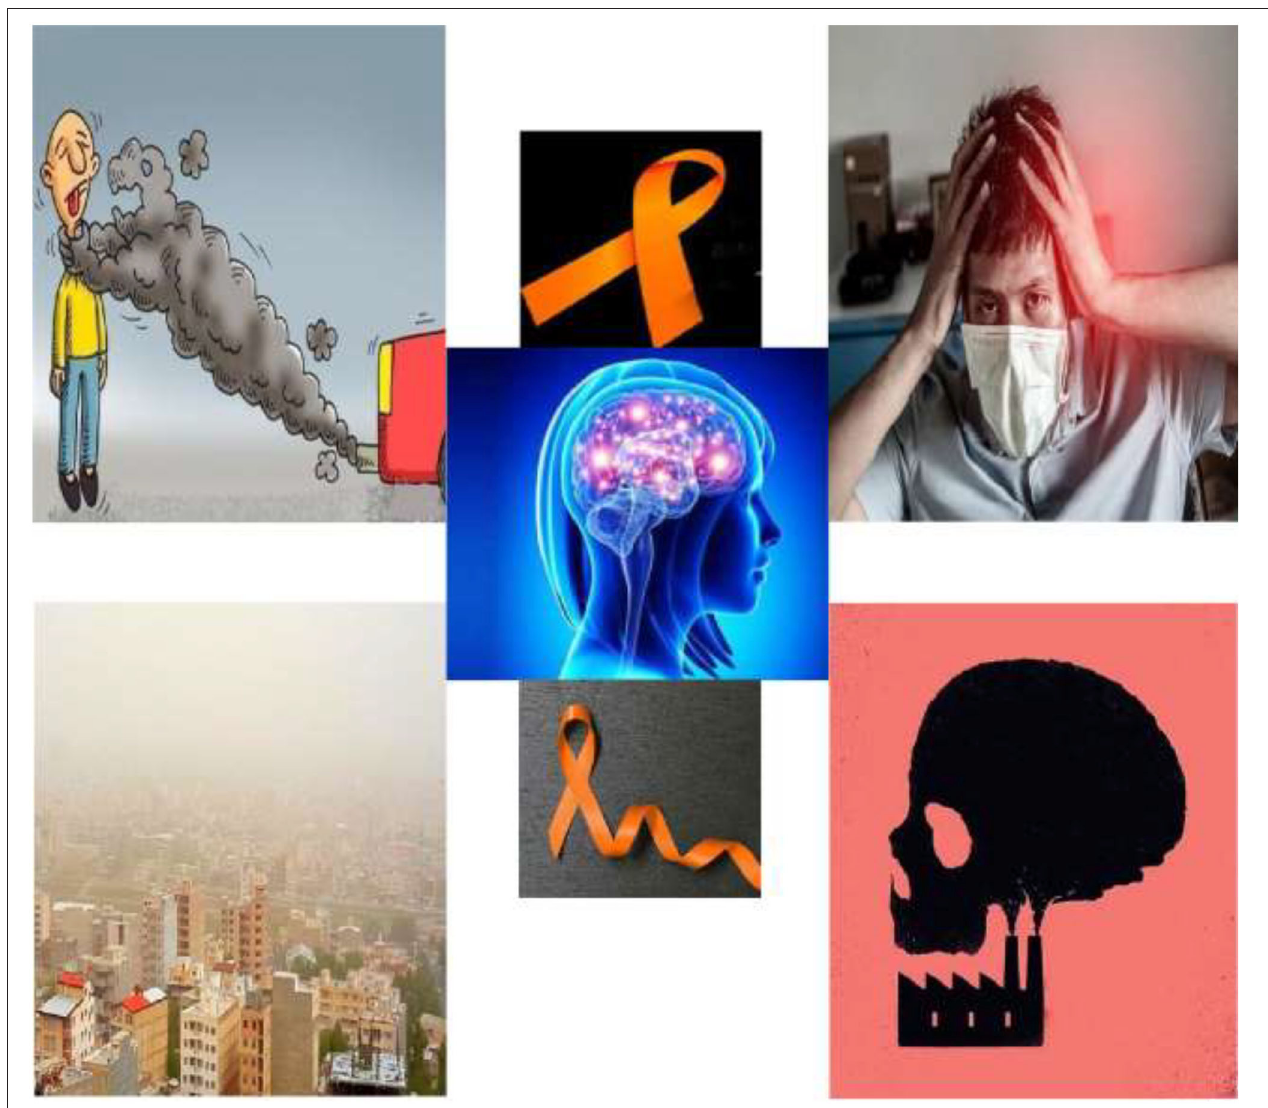
FIGURE 4 | Sources of toxic air pollutants and its effects on multiple sclerosis.